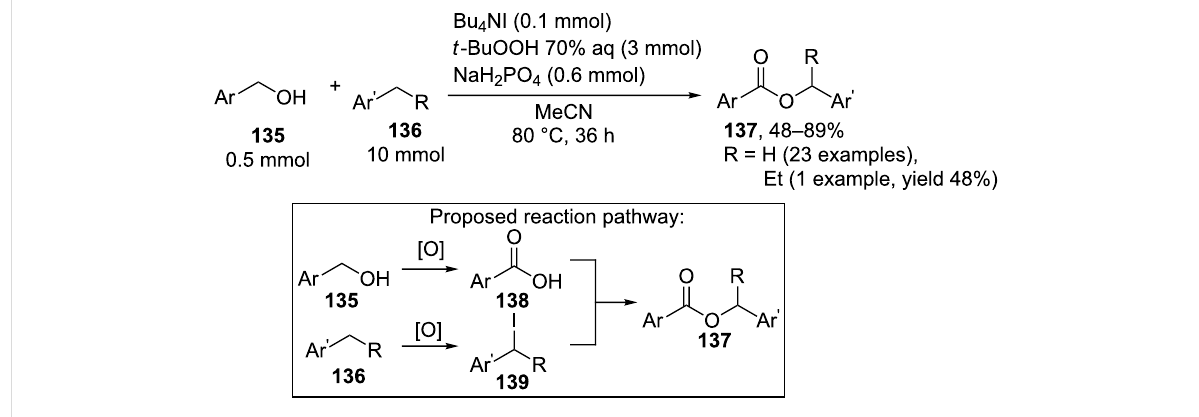
Scheme 27: Oxidative C–O coupling of benzyl alcohols with methylarenes under the action of Bu 4 NI/ t- BuOOH system in the presence of NaH 2 PO 4 .